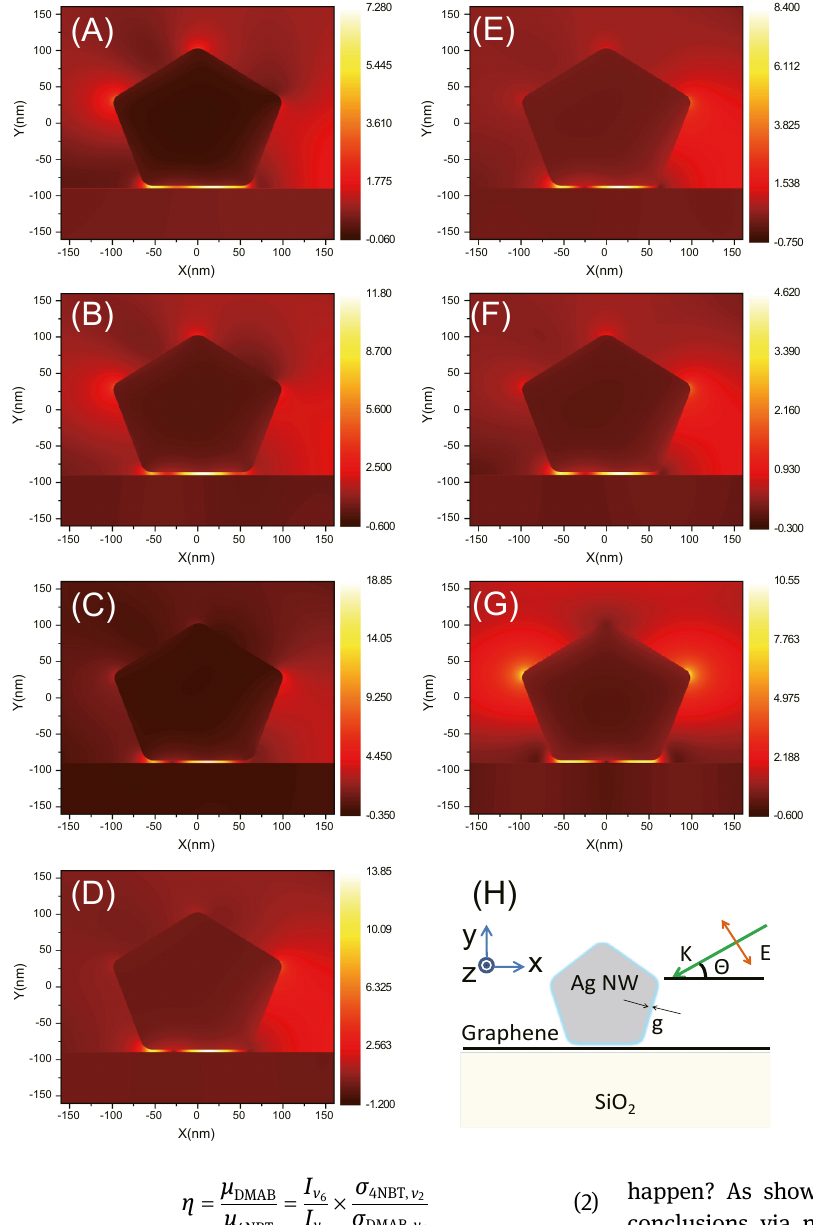
Figure 4: (A – G) The finite-difference time- domain (FDTD) simulation of the electro- magnetic field distributions on x-y plane of the surface of section ( z = 0) for the graphene-coupled NW hybrid gap structure with different incidence angle θ = 0 ° , 15 ° , 30 ° , 45 ° , 60 ° , 75 ° and 90 ° , respectively. The ranges of the x -axis and y -axis are − 200 to 200 nm. (H) The light incidence con fi gura- tion for the FDTD